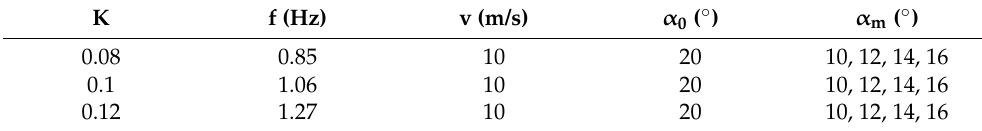
Table 8. Experimental conditions of varying pitch amplitude at different reduced